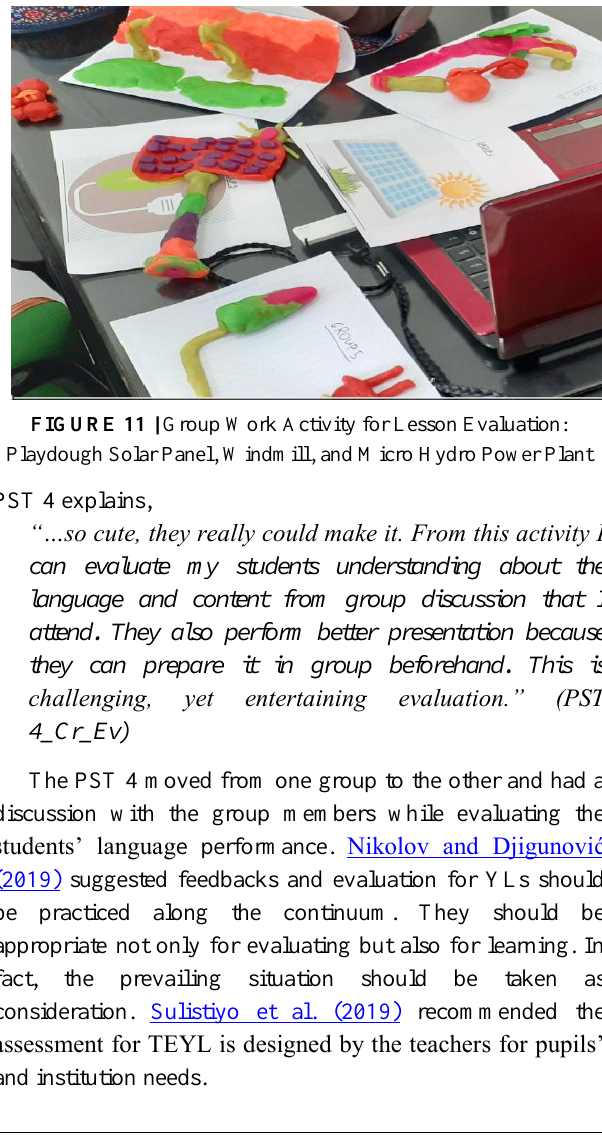
and institution